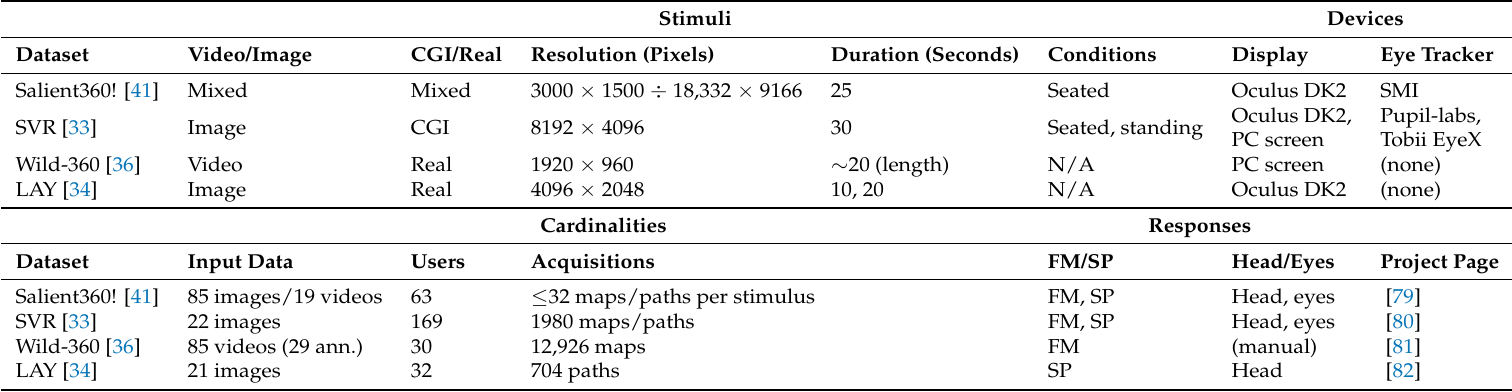
Table 3. Datasets for visual saliency in omnidirectional images and related characteristics (FM = Fixation maps, SP = Scanpaths). Stimuli